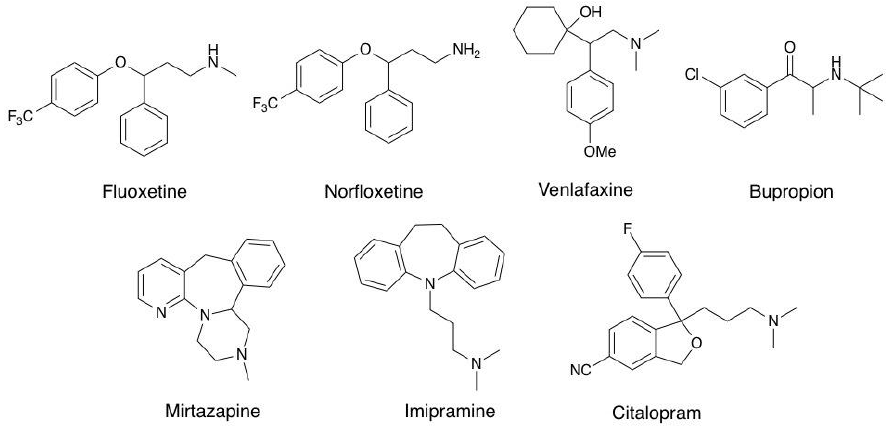
Figure 1. Chemical structures of antidepressants that modulate the α7 nicotinic receptor.